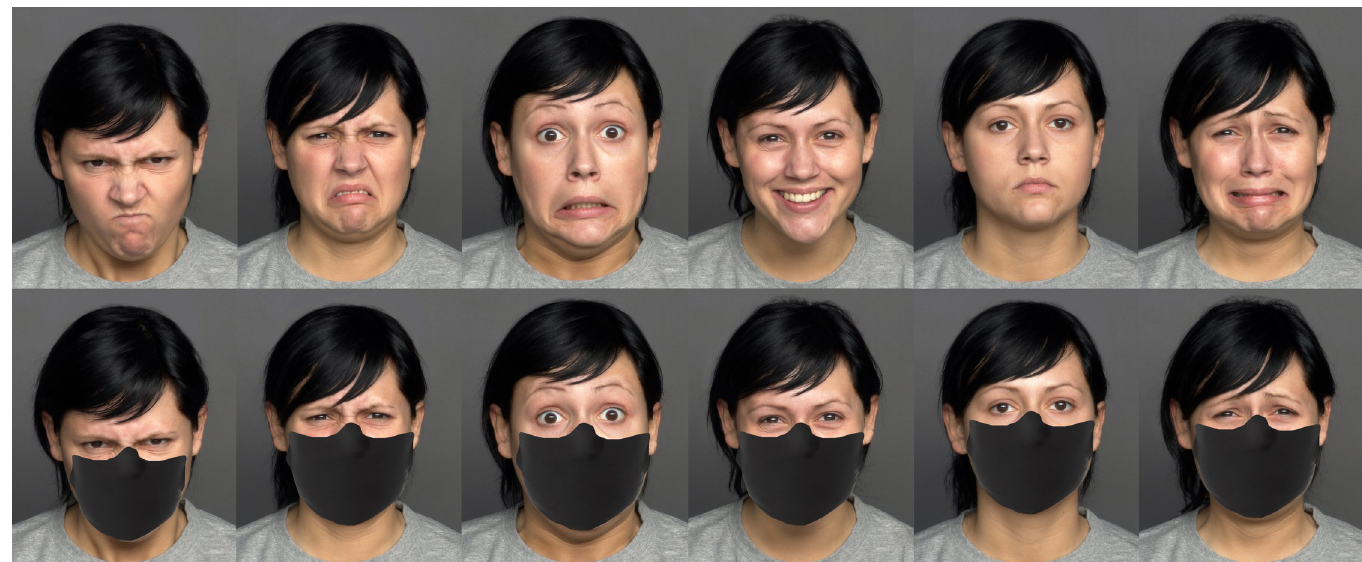
Fig 1. Example of six facial expressions of anger, disgust, fear, happiness, neutrality, and sadness (upper row) and their masked counterparts (lower row). Original material from top row stems from MPI FACES database (Ebner et al., 2010).